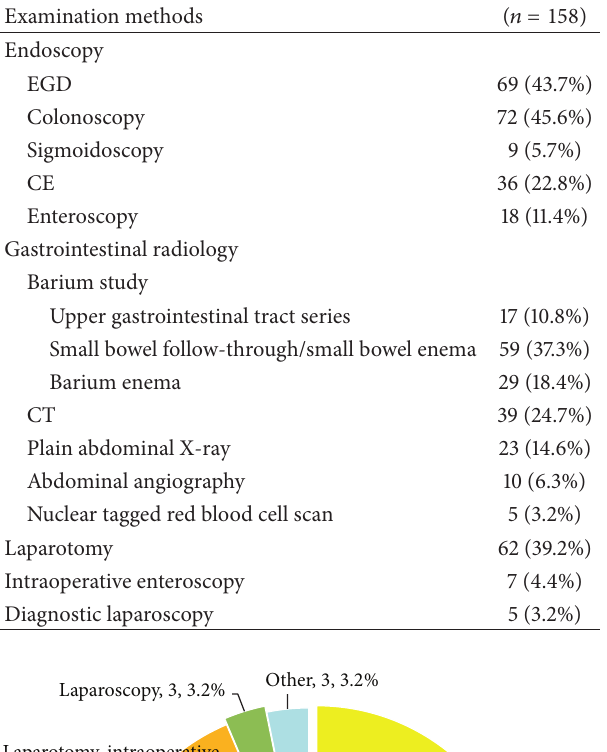
Table 3: Examination methods.